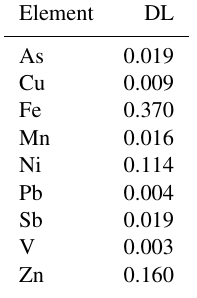
Table 2. Detection limits (DLs; 3 × SD) were determined from the mean standard deviations of seven clean blanks with ablation areas of 1.1cm 2 . DLs were converted to concentrations using the NIST standard and a theoretical air sampling period of 24h at 30Lmin − 1 . All values were spike corrected. Units are in ngm − 3